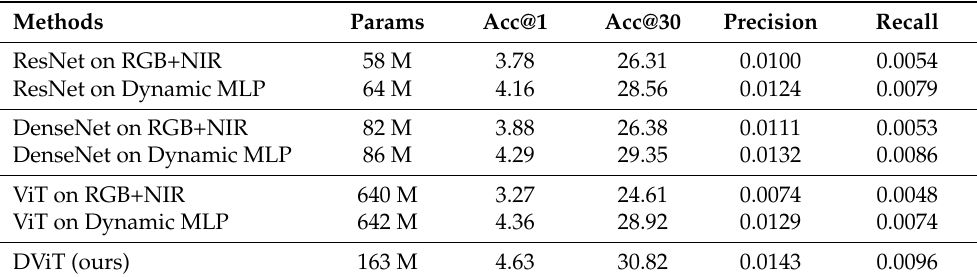
Table 7. For the validation set: the top-1 accuracy, top-30 accuracy, precision, and recall metrics comparison of the DViT with the image-only and multimodal fusion Dynamic MLP using GeoLife- CLEF 2021.